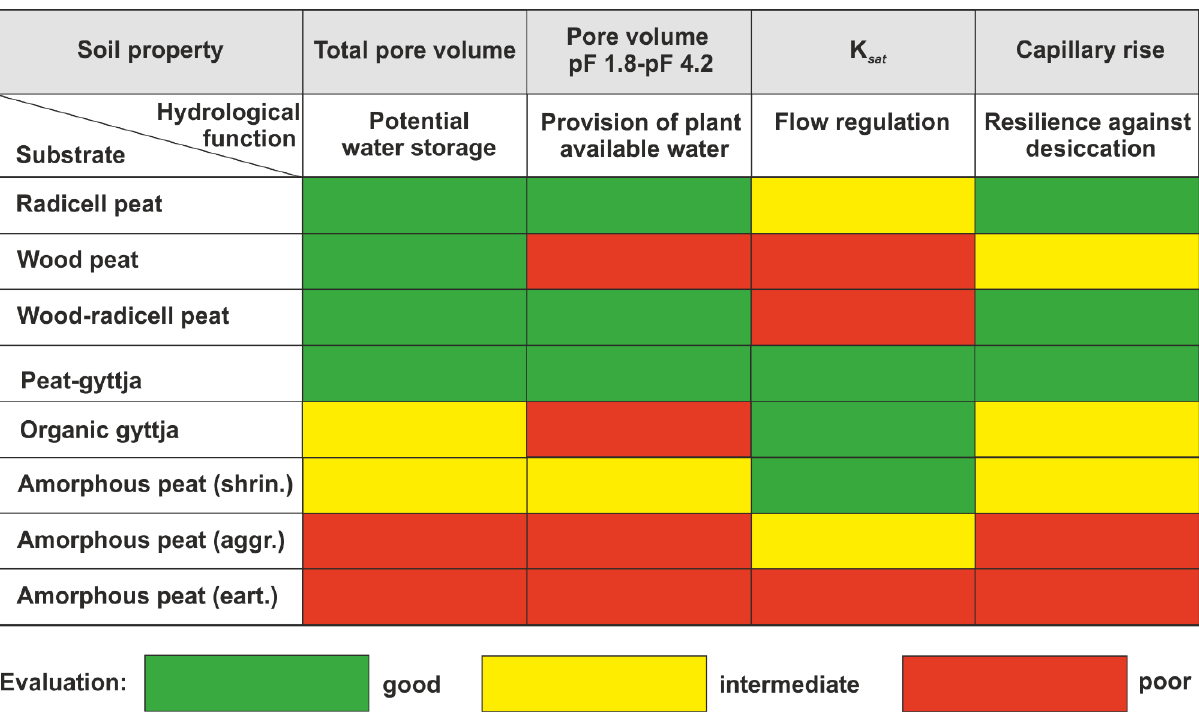
Figure 10. Comparison of the peatland substrates examined here, according to their soil physical properties and evaluation of their hydrological functions. For amorphous peat (eart.), ‘provision of plant available water’ and ‘capillary rise’ were evaluated on the basis of information from literature (Zeitz 2001, |Zeitz & Velty 2002, Schäfer 1996, Schindler et al .